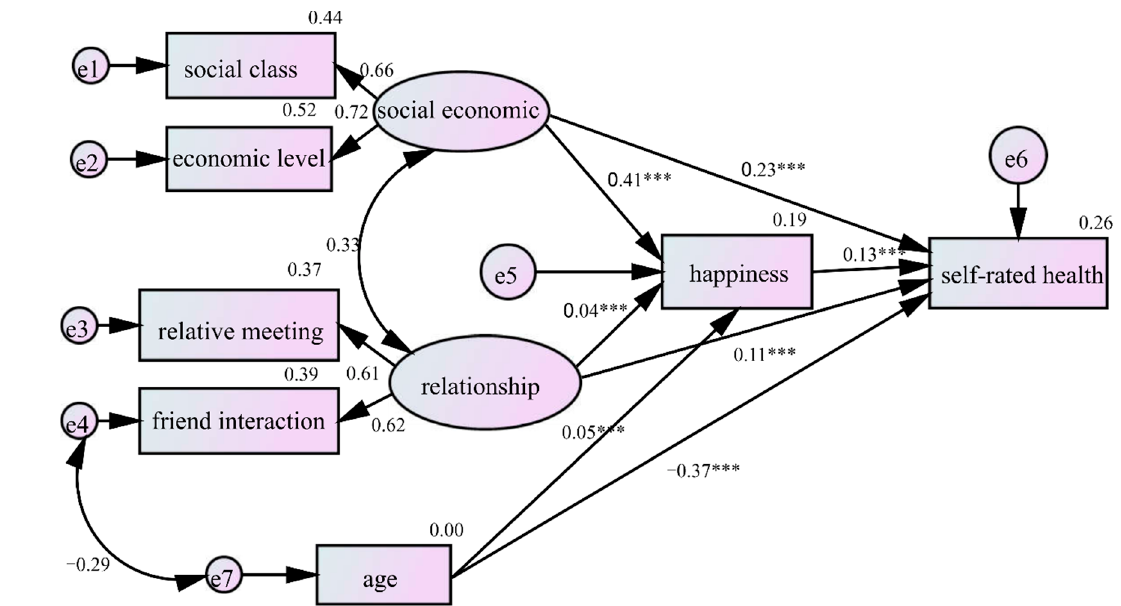
Figure 3. Results of the structural model (standardized outcome). *** p < 0.01. Table 9. Path coefficients of structural model. Abbreviations: standard errors